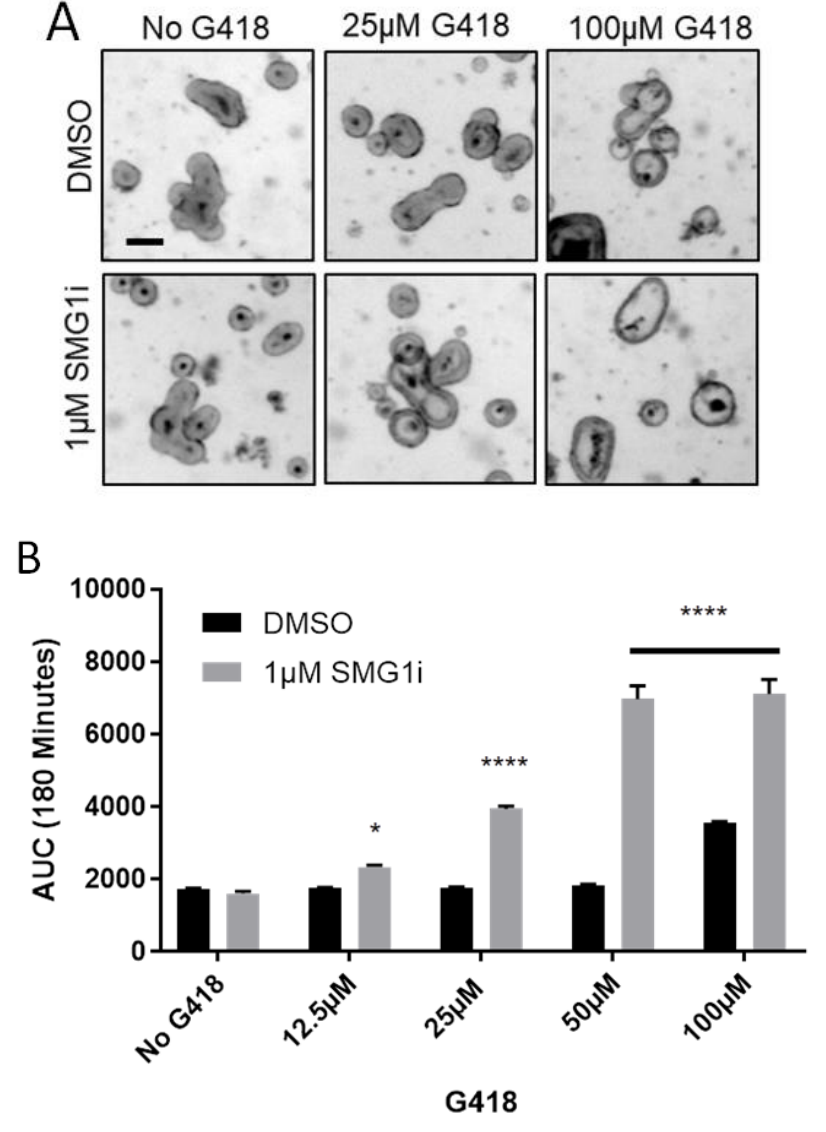
Figure 3. Low levels of readthrough are improved by inhibiting NMD. ( A ). Representative brightfield images of G542X intestinal organoids at 180 min following stimulation with 10 µ M forskolin. Scale bar is 100 µ m. ( B ). AUC measurements from swelling curves of G542X intestinal organoids treated with the indicated doses of G418 and/or 1 µ M SMG1i. n = 3, * p < 0.01, **** p < 0.0001 vs. DMSO by two-way ANOVA with post-hoc Tukey test.